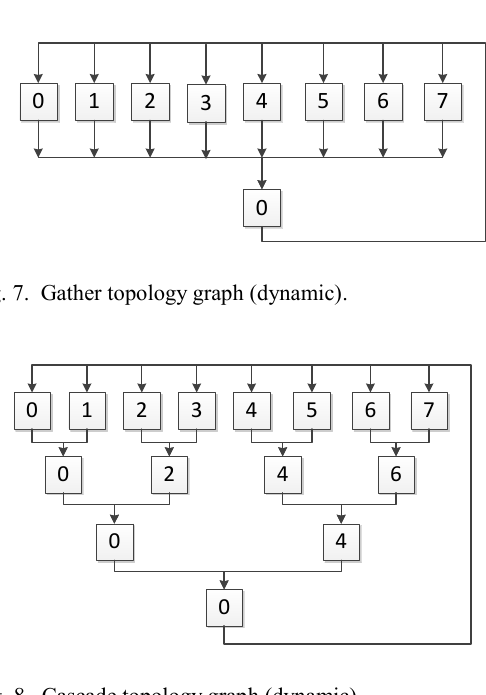
Fig. 8. Cascade topology graph